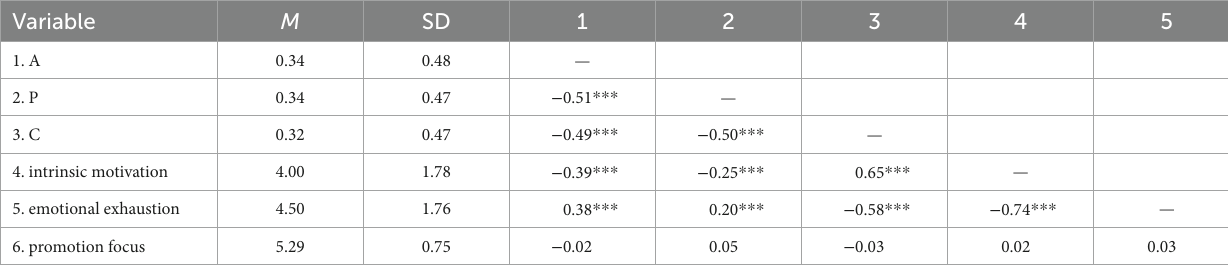
TABLE 1 Descriptive statistics and correlations among Study 1